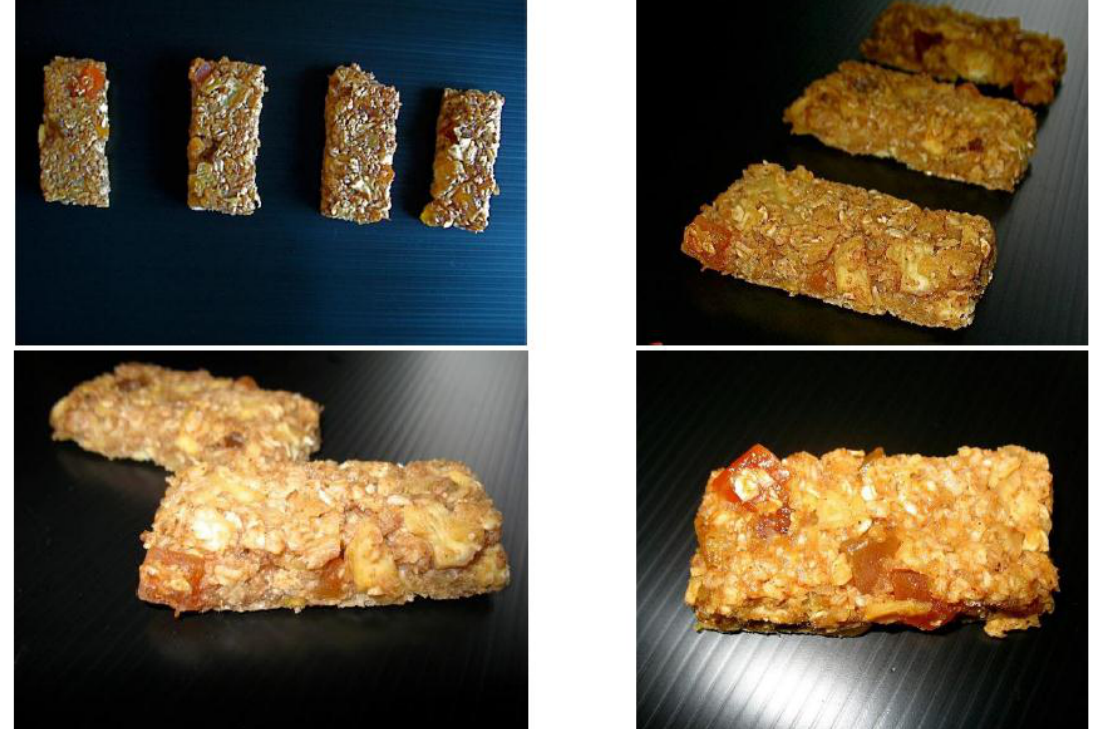
Figure A1. Breadfruit bar © 2014 Mark Figure A. Breadfruit bar © 2014 Mark Wilkens.